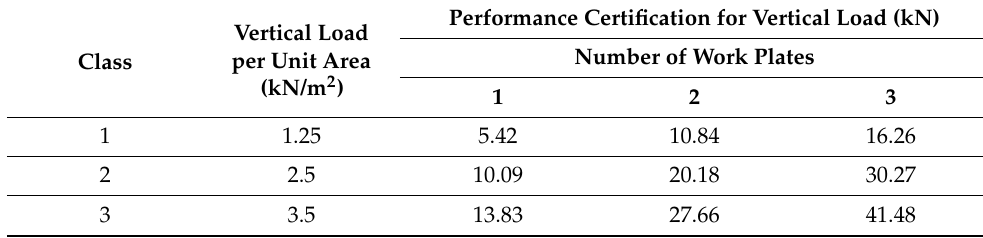
Table 18. Calculation of suggested safety certification standards for fabricated mobile scaffold for vertical loads based on specimens.